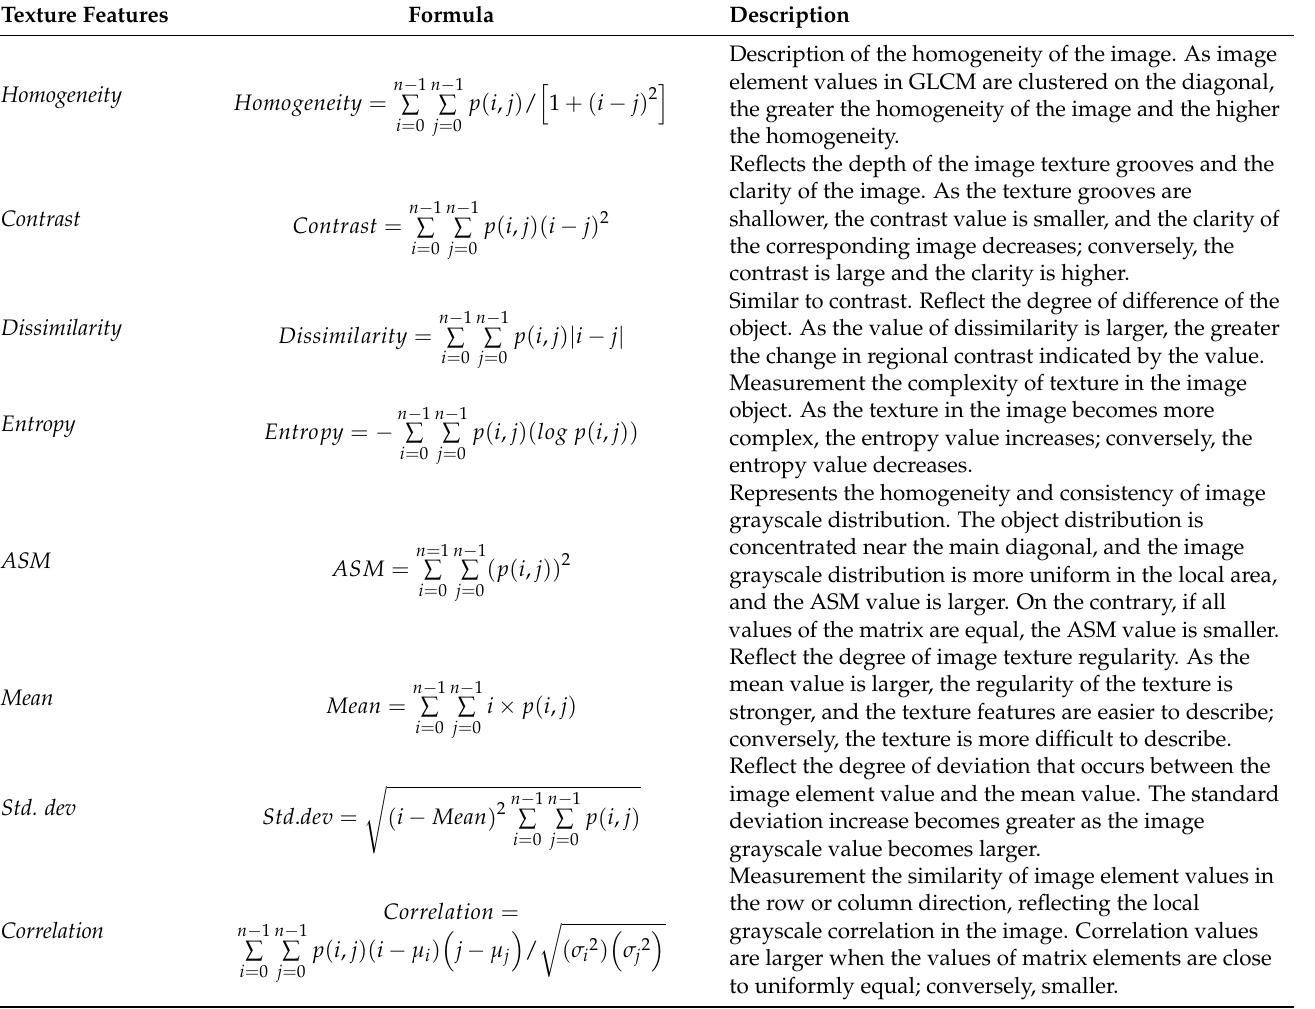
Table 4. An equation and explanation for the texture